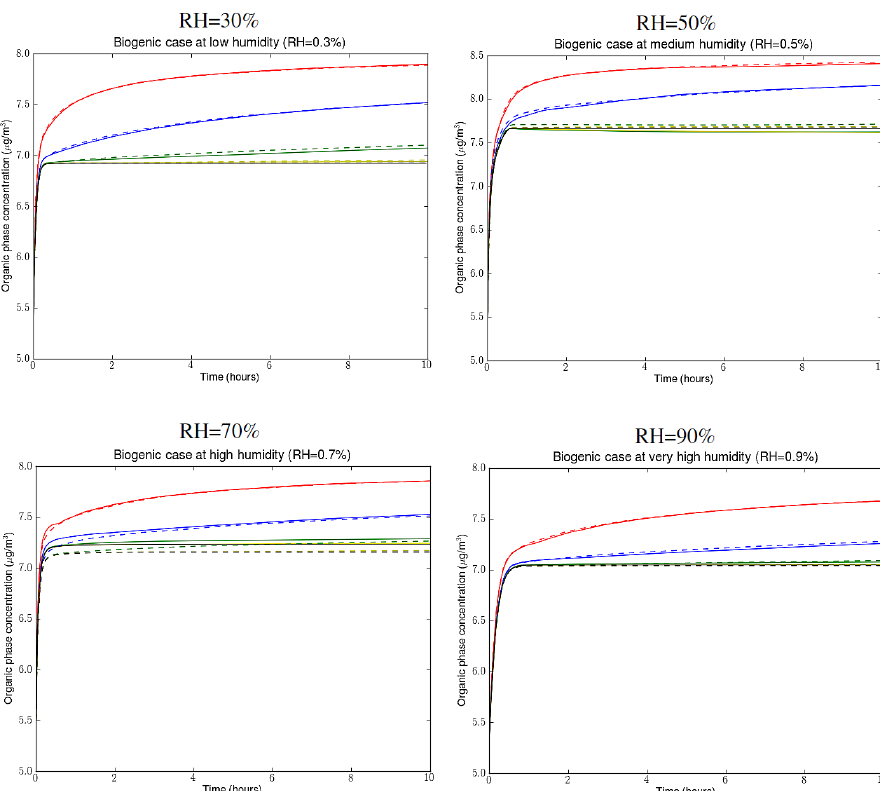
Figure 8. Evolution of concentrations in organic phases for the biogenic case at various humidities, with initial concentrations equal to one tenth of the concentrations at equilibrium and 5µgm − 3 of non-volatile compounds for N layer = 5 (plain lines) and N layer = 4 (dashed lines) for several organic-phase diffusivity: D org = 10 − 19 m 2 s − 1 (red), D org = 10 − 20 m 2 s − 1 (blue), D org = 10 − 21 m 2 s − 1 (green), D org =